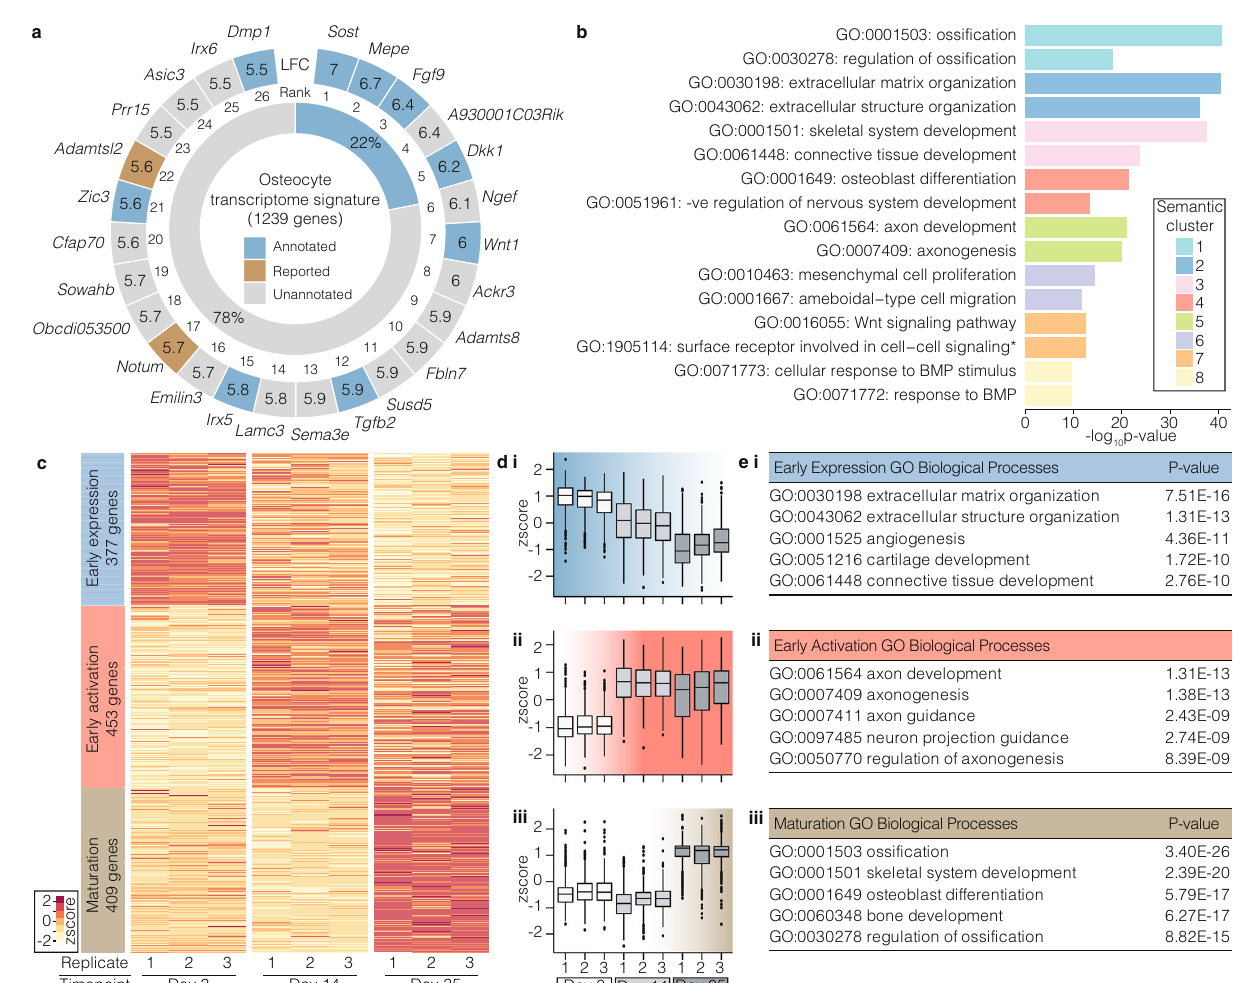
Fig. 4 Genes and control pathways identi fi ed by the osteocyte transcriptome signature. a The top 26 osteocyte transcriptome signature genes most enriched in osteocytes (outer ring). Genes annotated with either a skeletal biological process (GO database) or skeletal phenotype (MGI database) are highlighted blue; genes reported with experimental evidence of a role in the skeleton are brown, whereas unannotated genes without a skeletal annotation in GO or MGI and no experimental evidence of a role in the skeleton reported in the literature are shown in grey. Numbers denote log 2 fold-enrichment (LFC) in gene expression in osteocytes. The proportion of all osteocyte transcriptome signature genes annotated (blue) or unannotated (grey) with a skeletal annotation in GO or MGI is shown in the inner ring. b Clusters ( n = 8) of semantically similar biological processes (GO) signi fi cantly enriched in the osteocyte transcriptome signature are identi fi ed by different colours (Bonferroni-corrected P < 0.05). The top 2 terms (by P -value) in each of the eight clusters are listed. c Heatmap showing clustering of osteocyte transcriptome signature genes based on distinct co-expression patterns during osteocytic- differentiation 50 of the IDG-SW3 cell-line, from osteoblast-like cells (day 3) to early (day 14) and mature osteocytes (day 35). The name and number of genes for each cluster are labelled. Cluster colours correspond to subsequent panels ( d – e ). d Changes in early expression cluster (i), early activation cluster (ii) and maturation cluster (iii) of genes during osteocyte differentiation. Tukey boxplots show the distribution of gene expression values for each cluster in cells from three independent experiments ( n = 3). Boxes indicate median and interquartile range (IQR) of scaled, normalised gene expression values, whiskers denote values ±1.5 × QR and outlier values beyond this range are shown as individual points. e Biological processes (BP) enriched in the early expression cluster (i), the early activation cluster (ii) and the maturation cluster (iii). The top 5 GO BP terms in each cluster with P -values (Bonferroni adjusted) calculated by hypergeometric